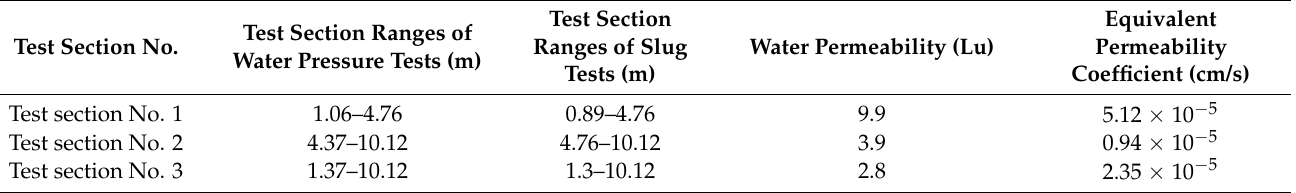
Table 5. Water permeability of three group water pressure tests and fracture equivalent permeability coefficient determined by slug tests of the corresponding test